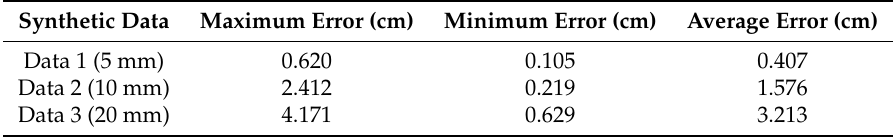
Figure 25. Accuracy evaluation on the synthetic data. First row: Point clouds with 5 mm, 10 mm, 20 mm Gaussian noise. Second row: Errors from the proposed method. Table 4. Evaluation of synthetic data with different Gaussian